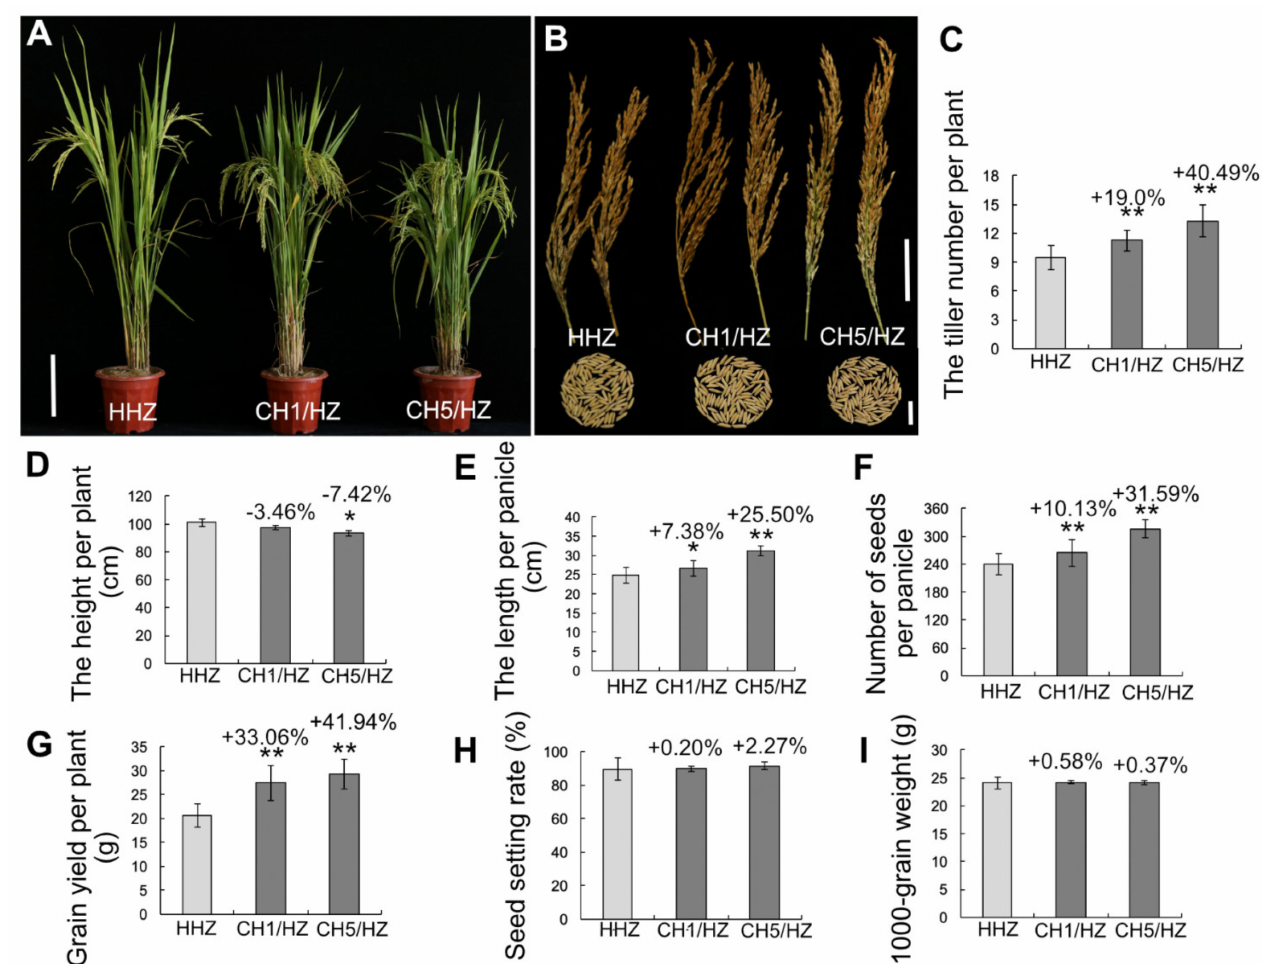
Figure 1. Yield traits of HHZ and OsHXK1-Cas9 plants seeded in the fall. ( A ) Images of HHZ, CH1/HZ, and CH5/HZ plants at the flowering stage. Bar = 20 cm. ( B ) Comparisons of panicles and 100 grains of HHZ, CH1/HZ, and CH5/HZ plants. Bar = 5 cm (top), 2 cm (bottom). ( C ) Tiller number of HHZ, CH1/HZ, and CH5/HZ plants. ( D ) Height of HHZ, CH1/HZ, and CH5/HZ plants. ( E ) Length per panicle of HHZ, CH1/HZ, and CH5/HZ plants. ( F ) Number of grains per panicle of HHZ, CH1/HZ, and CH5/HZ plants. ( G ) Single-plant yield of HHZ, CH1/HZ, and CH5/HZ plants. ( H ) Seed setting rate of HHZ, CH1/HZ, and CH5/HZ plants. ( I ) 1000-grain weight of HHZ, CH1/HZ, and CH5/HZ plants. The data are the means ± SDs; *, 0.01 ≤ p < 0.05; **, 0.001 ≤ p < 0.01 according to Student’s t